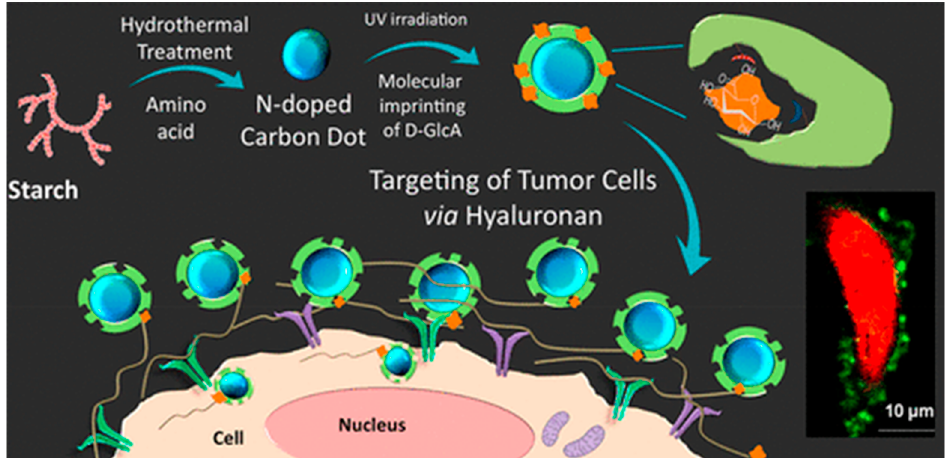
Figure 8. Synthesis and mode of action of CD coupled to a MIP coating to target tumor cells. Reproduced with permission [93] © 2021 American Chemical Society .